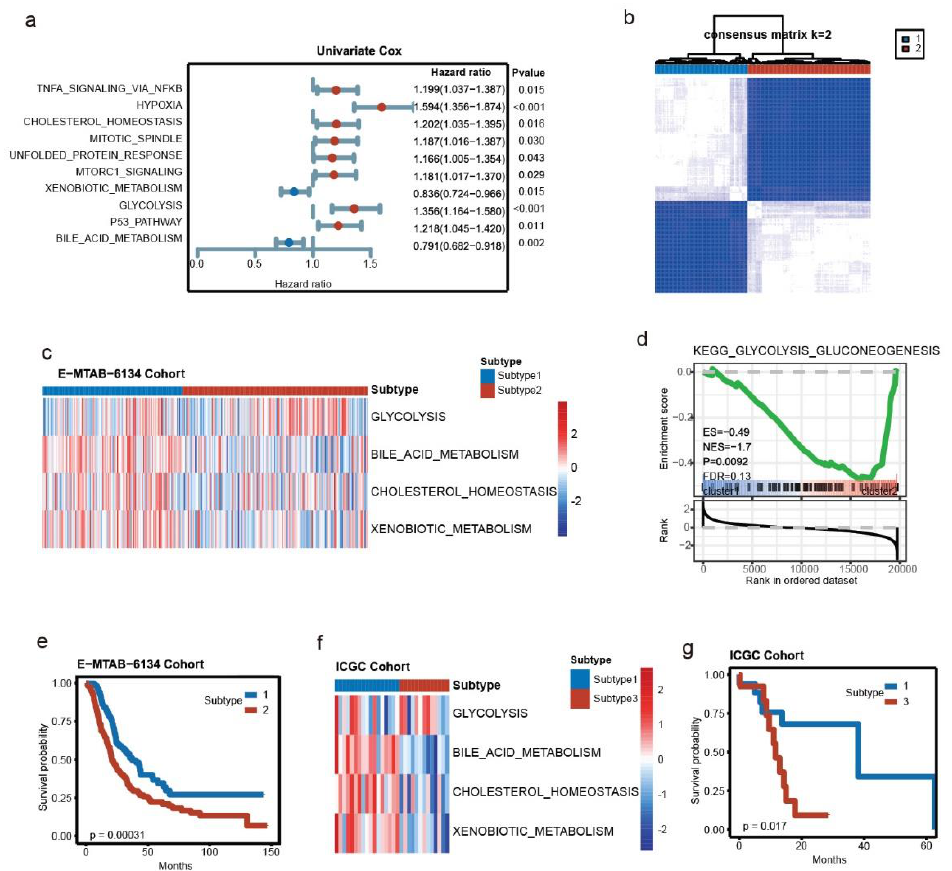
Figure 2. Key metabolic pathways of PDAC and molecular subtyping. ( a ) Univariate Cox regression indicated that glycolysis, bile acid metabolism, cholesterol homeostasis and xenobiotic metabolism were prognostic indicators in PDAC ( n = 288). ( b ) Two clusters were determined by consensus clustering in the E-MTAB-6134 cohort ( n1 = 123, n2 = 165). ( c ) Differences in the 4 metabolic pathways between the two clusters in the E-MTAB-6134 cohort. ( d ) GSEA of the glycolysis pathway between the two subtypes in the E-MTAB-6134 cohort. ( e ) Kaplan–Meier survival analysis between the two subtypes in the E-MTAB-6134 cohort. ( f ) Differences in the 4 metabolic pathways between Cluster 1 ( n = 17) and Cluster 3 ( n = 13) in the ICGC cohort. ( g ) Kaplan–Meier survival analysis between Cluster 1 and Cluster 3 in the ICGC